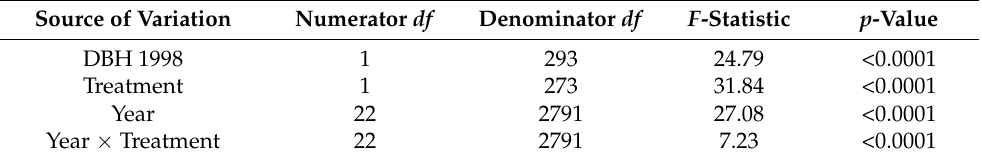
Table 2. ANOVA Table for Ring Width Data at Taylor Creek. Highlighted values represent p < 0.05 indicating that all parameters had a significant influence on the variation of mean tree-ring widths.